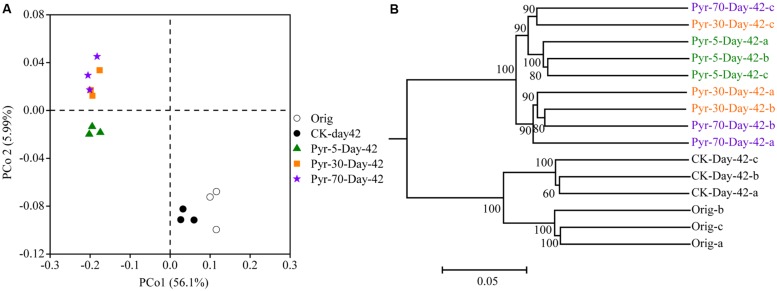
Principal coordinate analysis (PCoA) (A) and unweighted pair group method with arithmetic mean cluster analysis (B) of microbial communities based on weighted UniFrac distances at a depth of 10,000 randomly sampled sequences per sample. The percentages in parentheses indicate the proportions of variation explained by each ordination axis. The numbers on the nodes indicate bootstrapping values for each node. The symbols “a”, “b”, and “c” near “Day-42” or “Orig” indicate triplicate microcosms for each treatment. All other designations are the same as those in Figure 2.